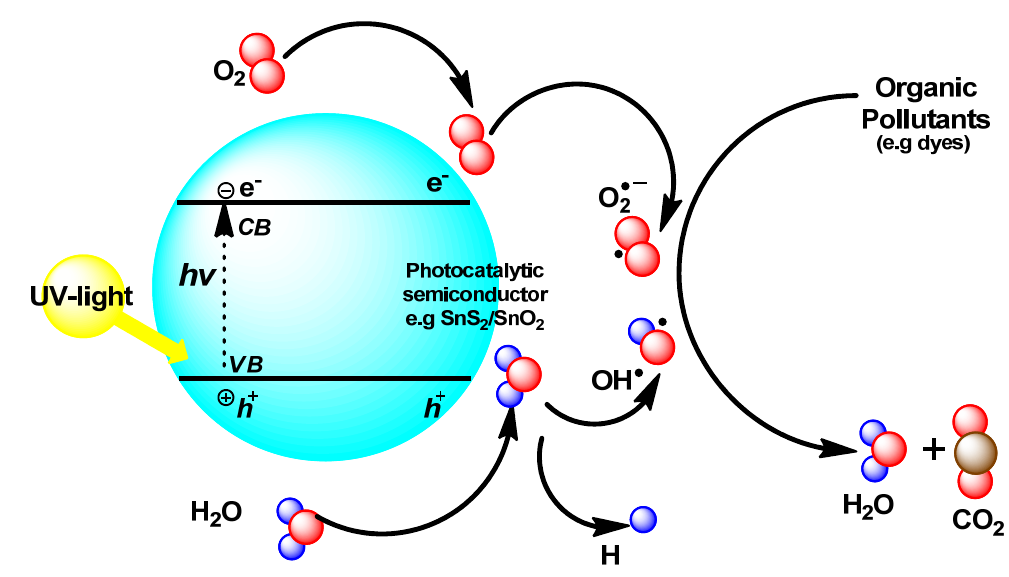
Figure 7. Schematic representation of the mechanism of degradation of organic pollutants through the irradiation of semiconductor and excitation of electrons in the valence band.